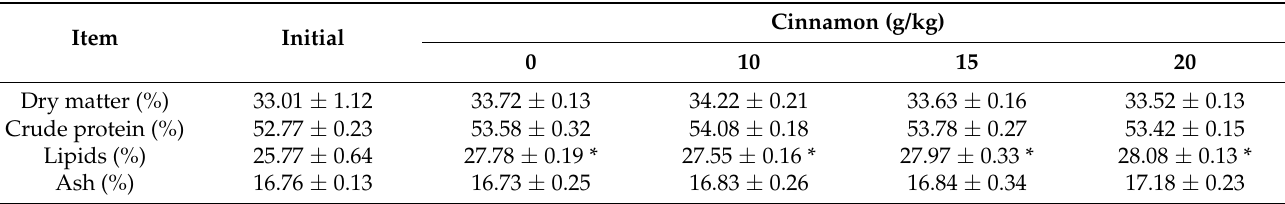
* Values in the same row with an asterisk are significantly different.